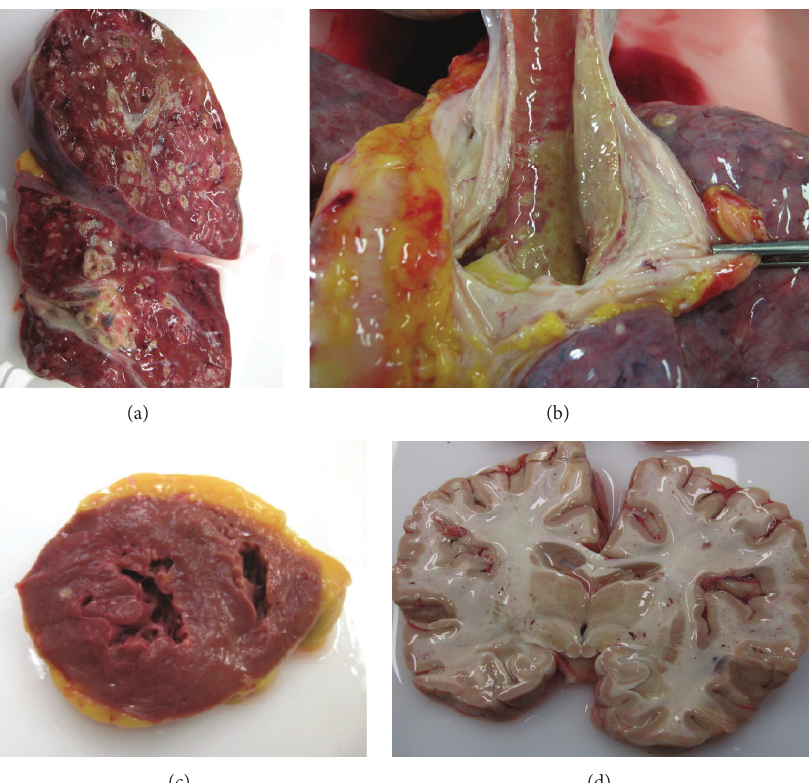
Figure 2: Pathological findings. (a) Lung. The image shows left and right lungs with bilateral necrotizing pneumonia with vascular invasion. Left lung weight: 875 gr. Right lung weight: 1040 gr. (b) Trachea. The trachea and main bronchi affected by invasive aspergillosis. (c) Heart. The whitenoduleintheleftventriclewasreportedasaspergilloma.(d)Brain.Severalhemorrhagicandnecroticareascausedbysepticmicroemboli of Aspergillus